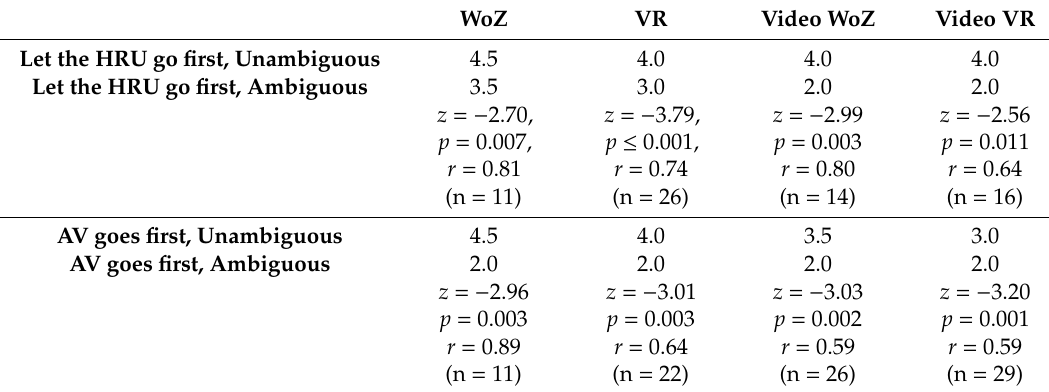
Table 11. Median ( Mdn ) of the evaluation of driving behavior (1 = very poor, 5 = very good), segregated by